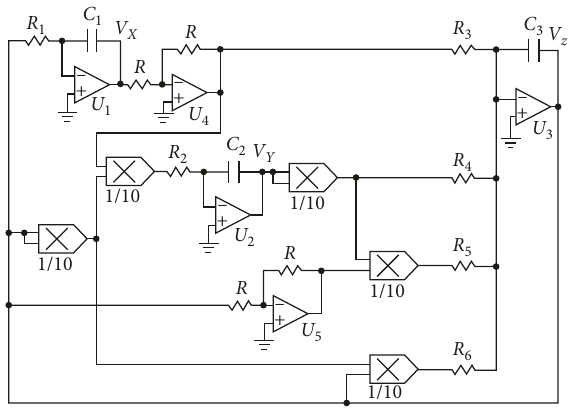
Figure 5: Schematic diagram of the designed circuit for system Phase portraits in Figure 6 are obtained by using the elec- tronic simulation package OrCAD-PSpice.